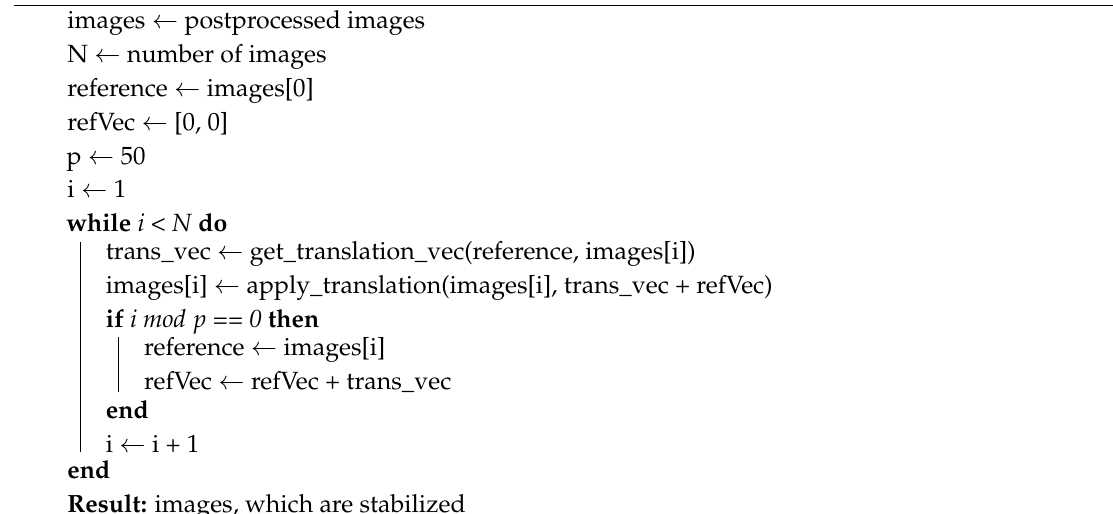
Algorithm 1: Pseudo code for video